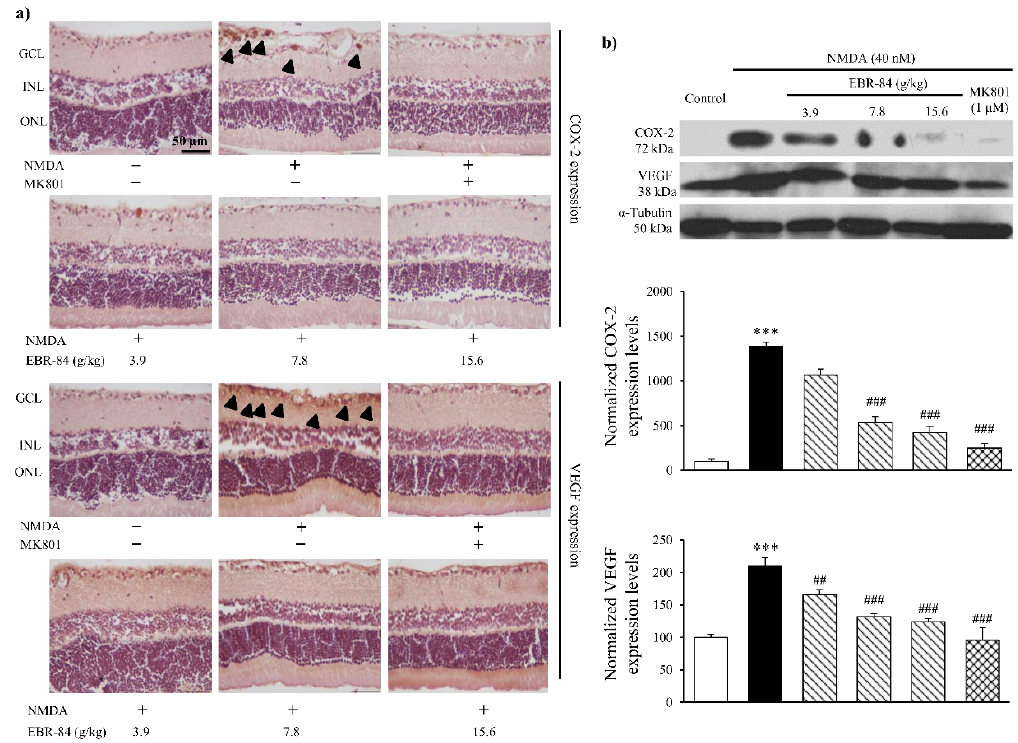
Figure 4. The effects of EBR-84 on the expression levels of COX-2 and VEGF in the retinas of NMDA-treated rats. ( a ) Representative images for immunohistochemical staining of COX-2 and VEGF in the rat retinas. The arrowheads denote the expression of COX-2 or VEGF. ( b ) Quantities of COX-2 and VEGF expression levels using Western blot analysis in the retina of rats ( n = 5). *** p < 0.001 vs. the control group; ## p < 0.01 and ### p < 0.001 vs. the NMDA group. The magnification of all figures is × 200. Scale bar is 50 µ m for all images.